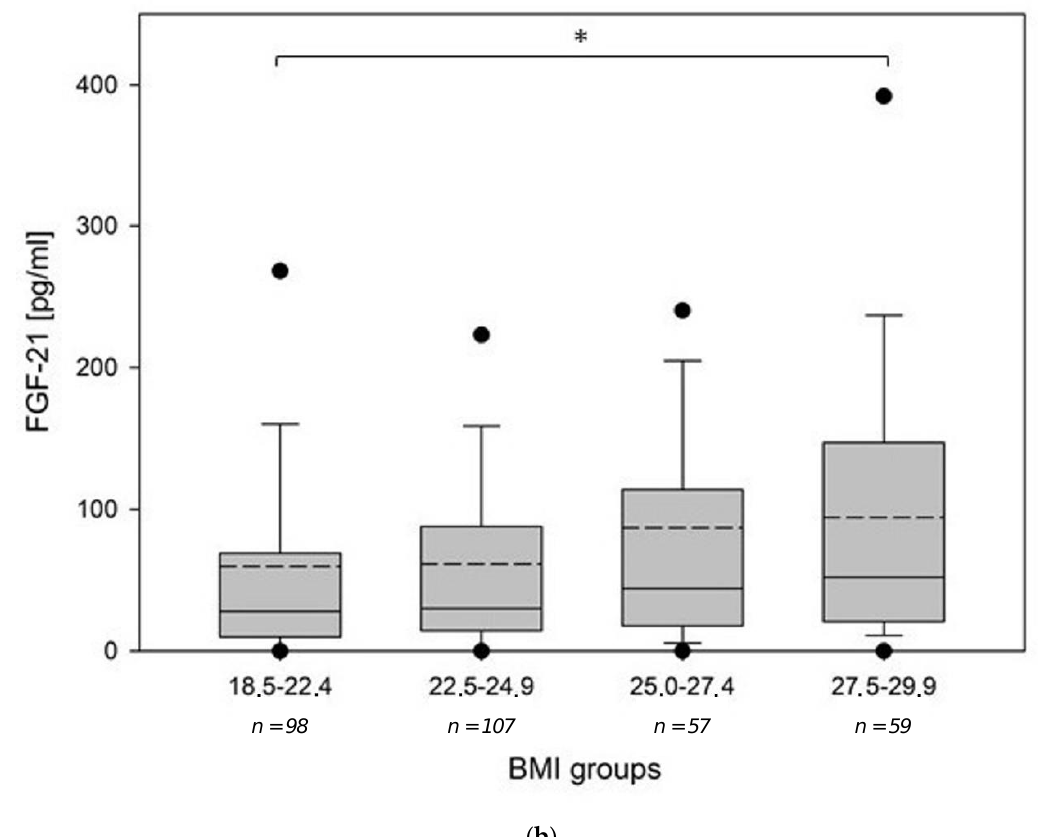
Figure 2. FGF-21- and GDF-15 values depending on age or BMI. ( a ) GDF-15 serum concentration within different age groups, ( b ) FGF-21 serum concentration within different BMI groups. Within the box plots, solid lines represent medians and dashed lines means. Outliers are displayed as 5 – 95% range (black dots). Significant differences ( p < 0.05) between the groups using pairwise multiple comparison on ranks (Dunn ’ s method) are marked with an asterisk.